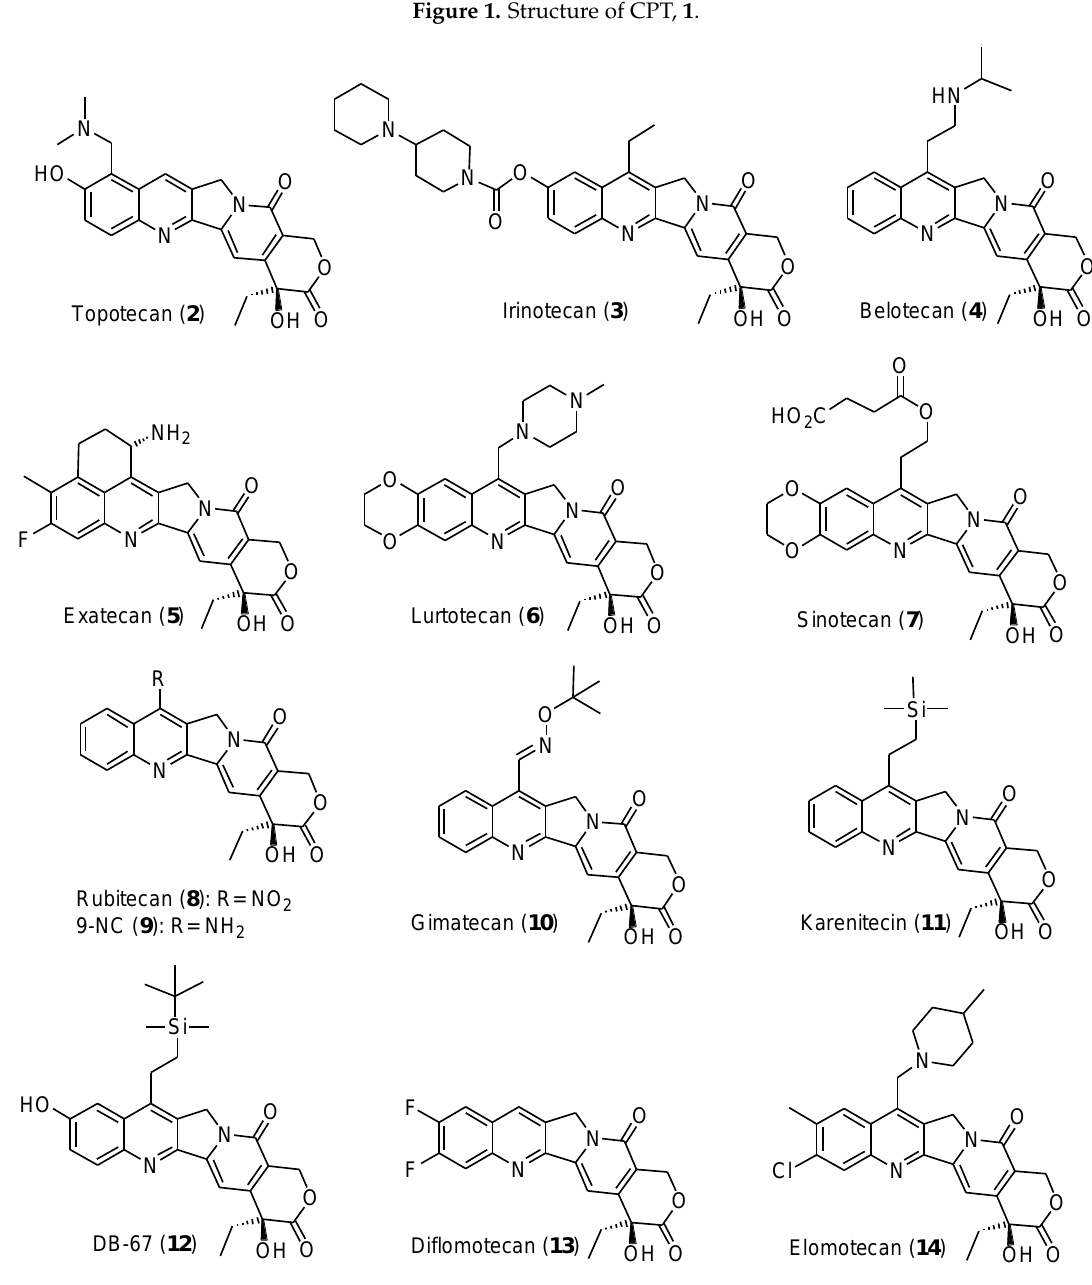
Figure 2. Structures of CPT analogues in use in clinical practice or clinical trials.